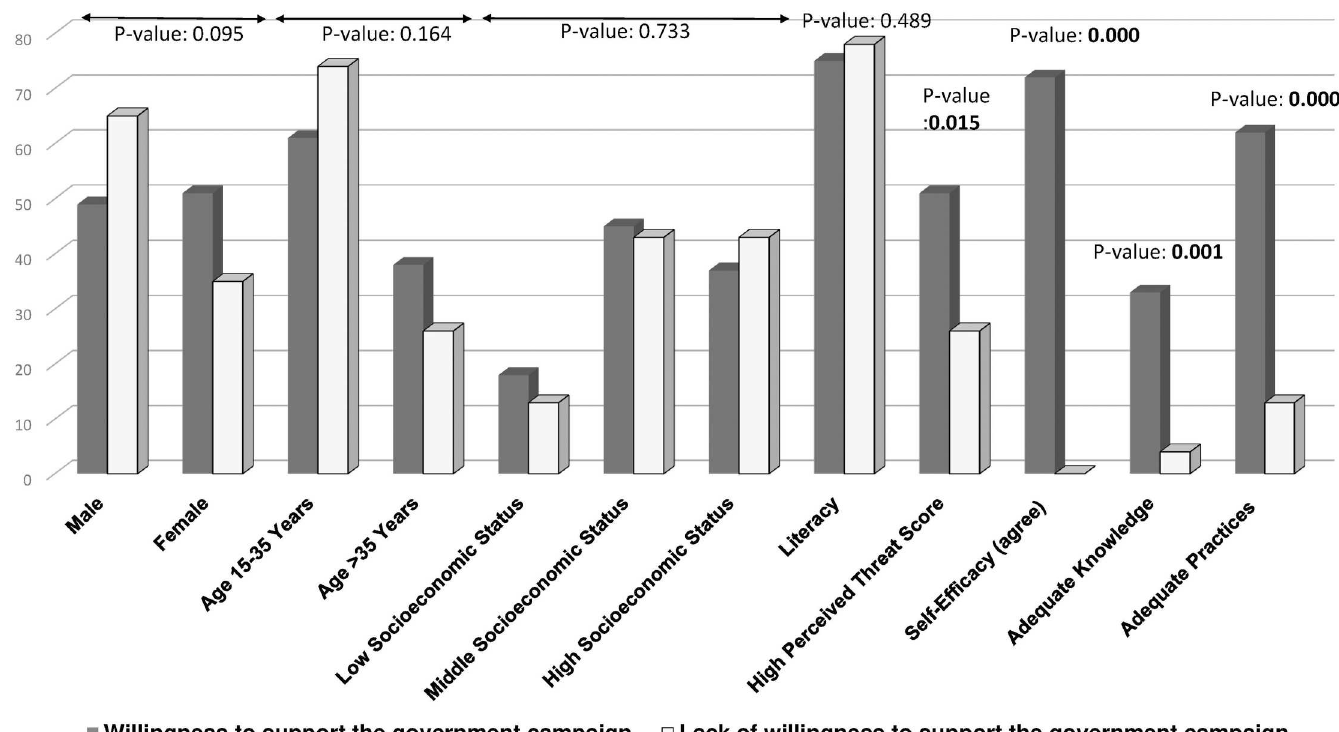
Fig 2. Willingness to Support the Government Campaign and Its Association with Demographics, Dengue Knowledge, Practices,and Health Beliefs. Bars represent the willingness to support the governmentcampaignfor denguepreventionaccordingto demographic characteristics, perceived threat of dengue, self-efficacy, and preventive practices. P-values shown in bold indicate a significant association.